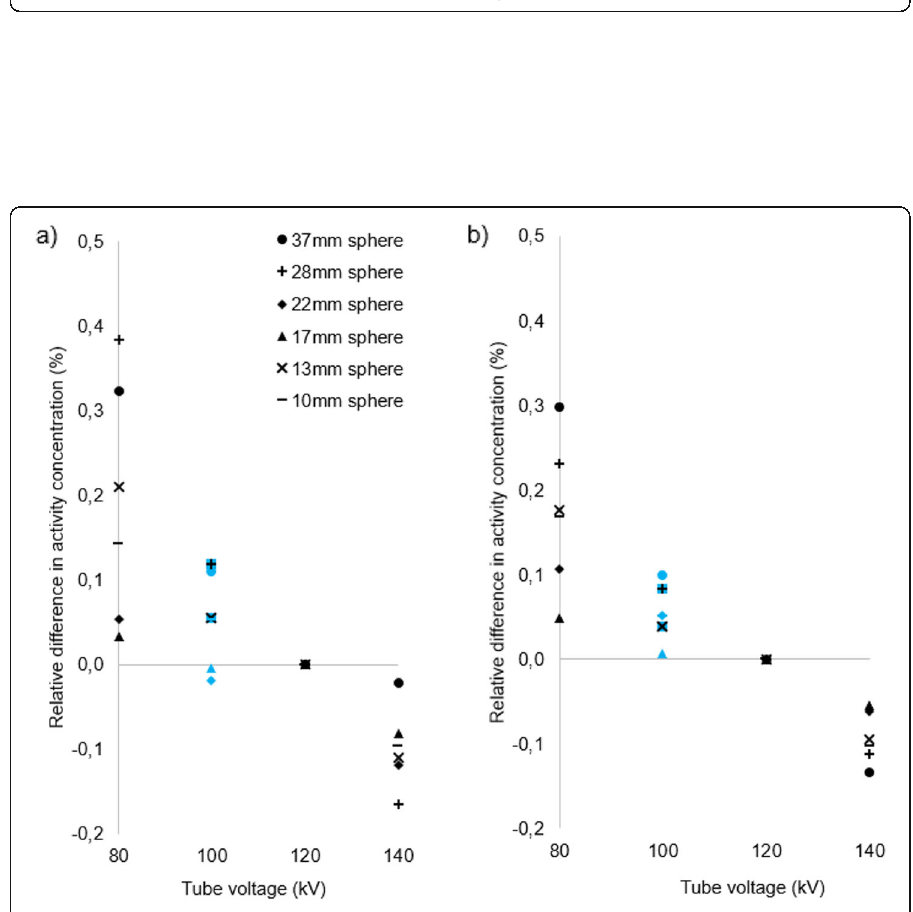
Fig. 6 Differences in a maximum and b mean activity concentration for each kV relative to 120 kV reference in NEMA IQ phantom. Data points also corresponding to ‘ CARE kV on ’ shown with blue markers. There are 6 data points per kV setting corresponding to VOIs over the 6 spheres with some data points overlapping, particularly at 0.00% difference in measured activity